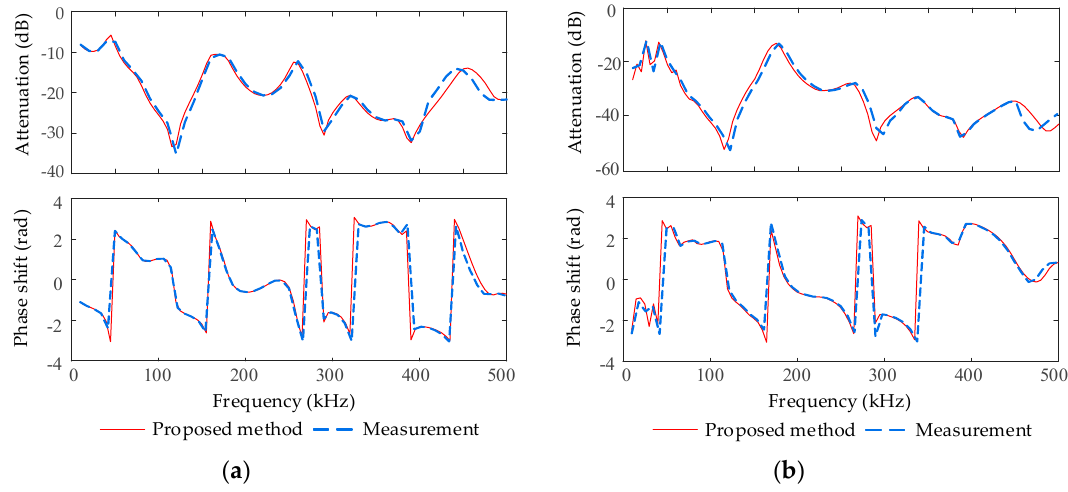
Figure 5. Frequency response characteristics of the radial distribution network with different coupling modes: ( a ) A phase core to B phase core (PP) coupling mode and ( b ) A phase core to ground (PG) coupling mode.